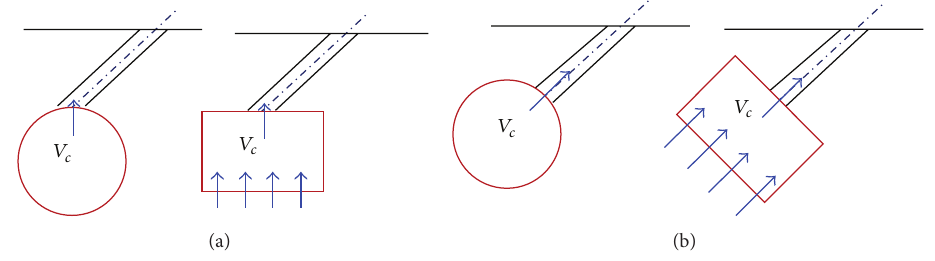
Figure 15: Schematic of two model inlet cooling flow